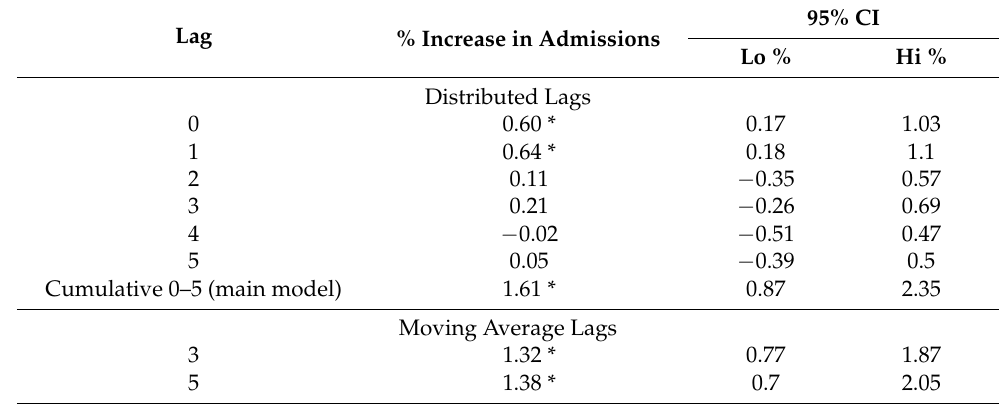
Table 2. Increase in total respiratory admission for 10 µ g/m 3 increase in PM 2.5 exposure for 0–5 lag days using distributed lag models and moving average of 3 and 5